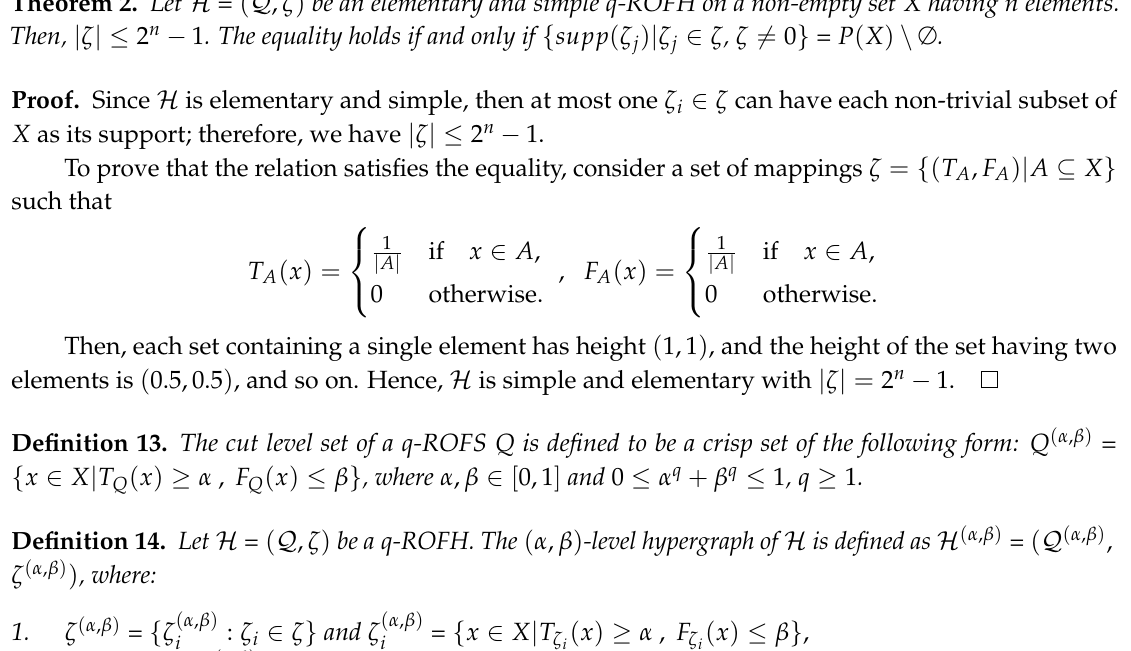
Table 1. Incidence matrix of